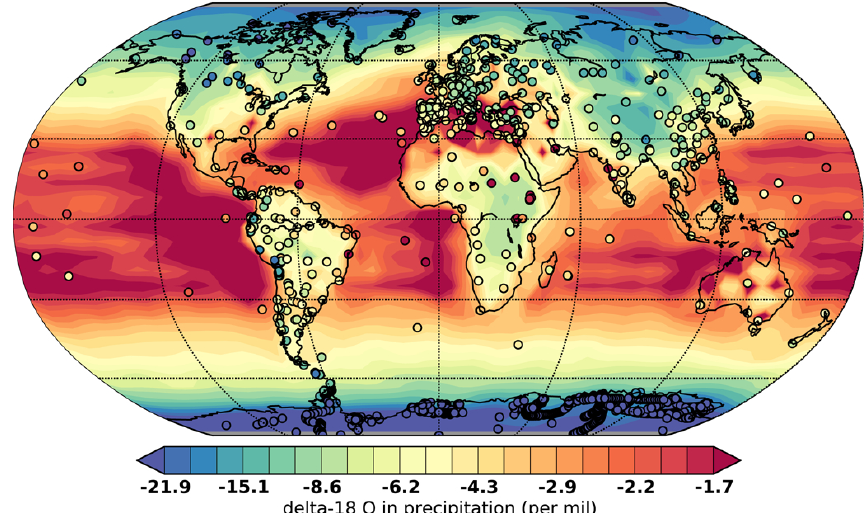
Fig. 1. Annual mean δ 18 O in precipitation in i LOVECLIM compared to the GNIP database (IAEA, 2006) and Masson-Delmotte et al. (2008) database for Antarctic snow isotopic composition (coloured